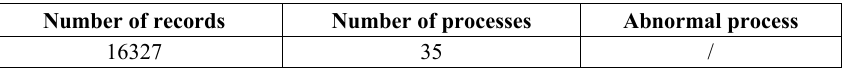
Table 1. Normal data test.